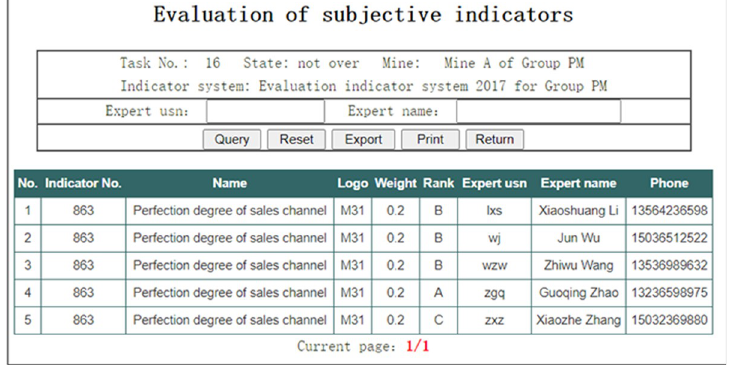
Fig 16. Evaluation data of final-level subjective indicators.